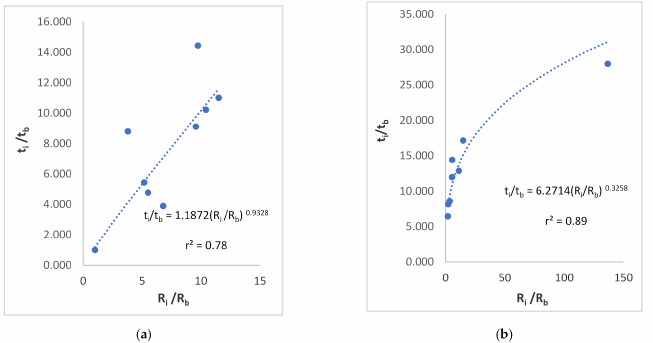
Figure 11. ( a ) The ninepreforms, Weavebirdloom. ( b ) The eightpreforms, Jacquard